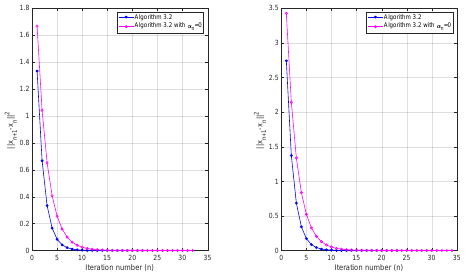
Algorithm 3.2 Algorithm 3.2 with